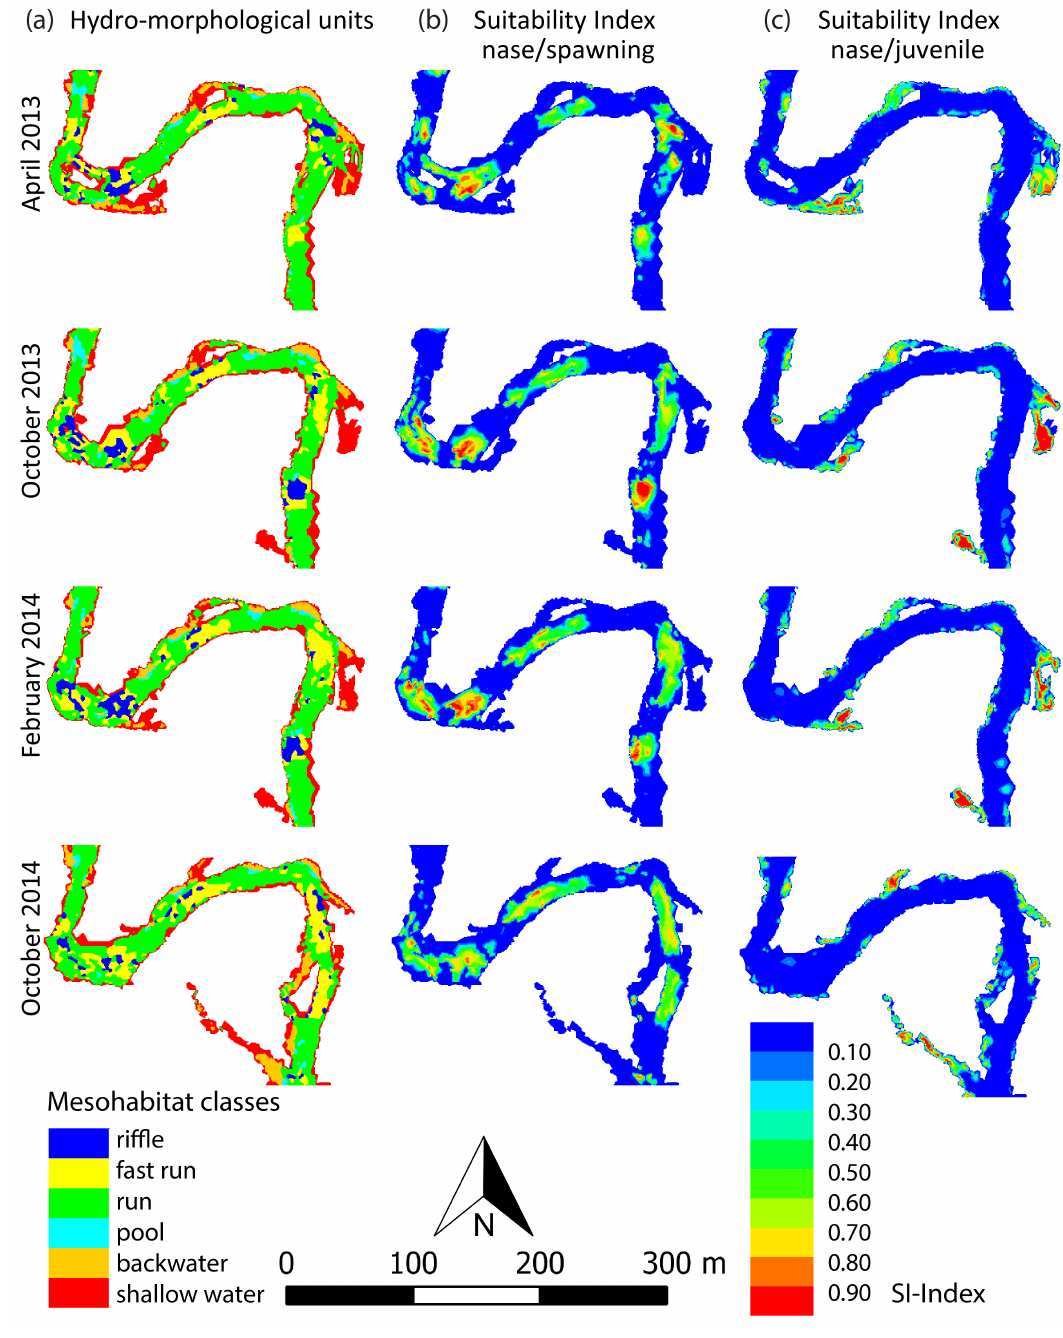
Figure 13. Application of LiDAR bathymetry for instream habitat studies on the mesohabitat scale ( a ) as well as on the microunit scale documenting the habitat suitabilities of ( b ) spawning of nase ( Chondrostoma nasus ); and ( c ) juvenile nase; all Figures are derived for mean flow conditions = 7.16 m 3 · s − 1 ; Suitability Index (SI)data based on [57]). Habitat modeling based on the topo-bathymetric LiDAR point cloud indicated that all six types of hydro-morphological units were present for the studied discharge range in all captured epochs ( cf. Figure 13). Important low-energetic habitats like shallow water and backwater sites are available for small fish for so called flow-pulse events within the bankfull width. The same preferred habitat types